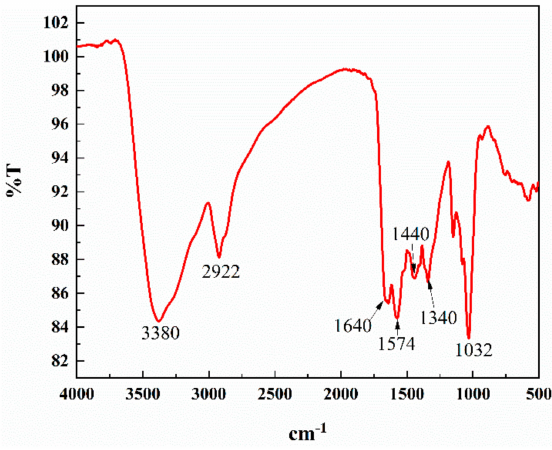
Figure 4. The FTIR spectrum of the N-CDs.